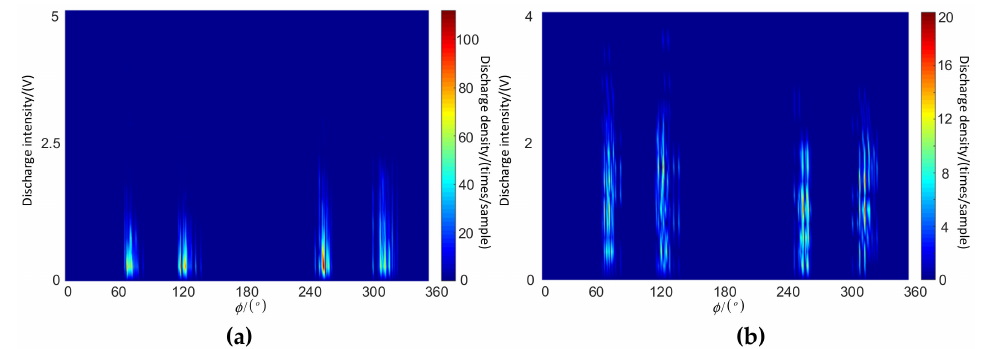
Figure 5. PRPD patterns of the floating defect under 20 kV. ( a ) A PRPD pattern of the optical detection and ( b ) a PRPD pattern of the UHF detection.